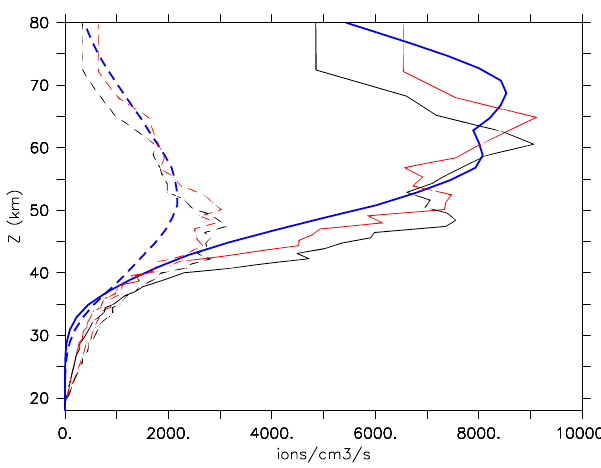
Fig. 1. Ionization rates for 28 and 29 October 2003 (dashed and solid lines, respectively) calculated by a column mode version of the SPE submodel using the original (black) and optimized (red) parameters for the energy-range relationship. Results provided by Jackman (2006) are shown in